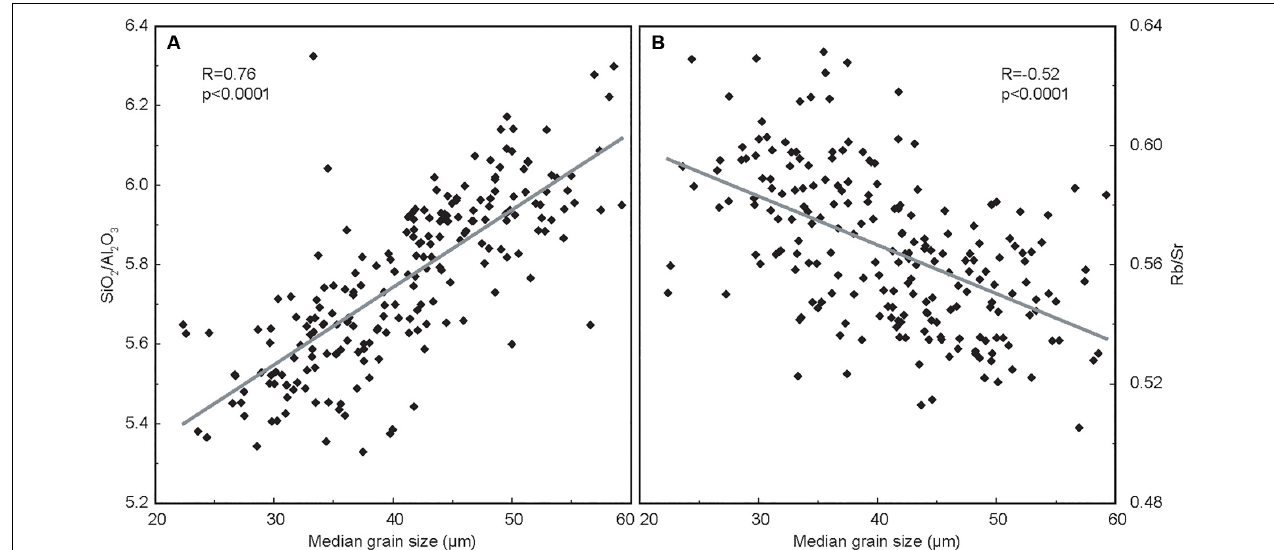
FIGURE 4 | Linear correlations between median grain size and element ratios in sediments from Core 38002-A. (A) Relationship between SiO 2 /Al 2 O 3 and median grain size, (B) Relationship between Rb/Sr and median grain